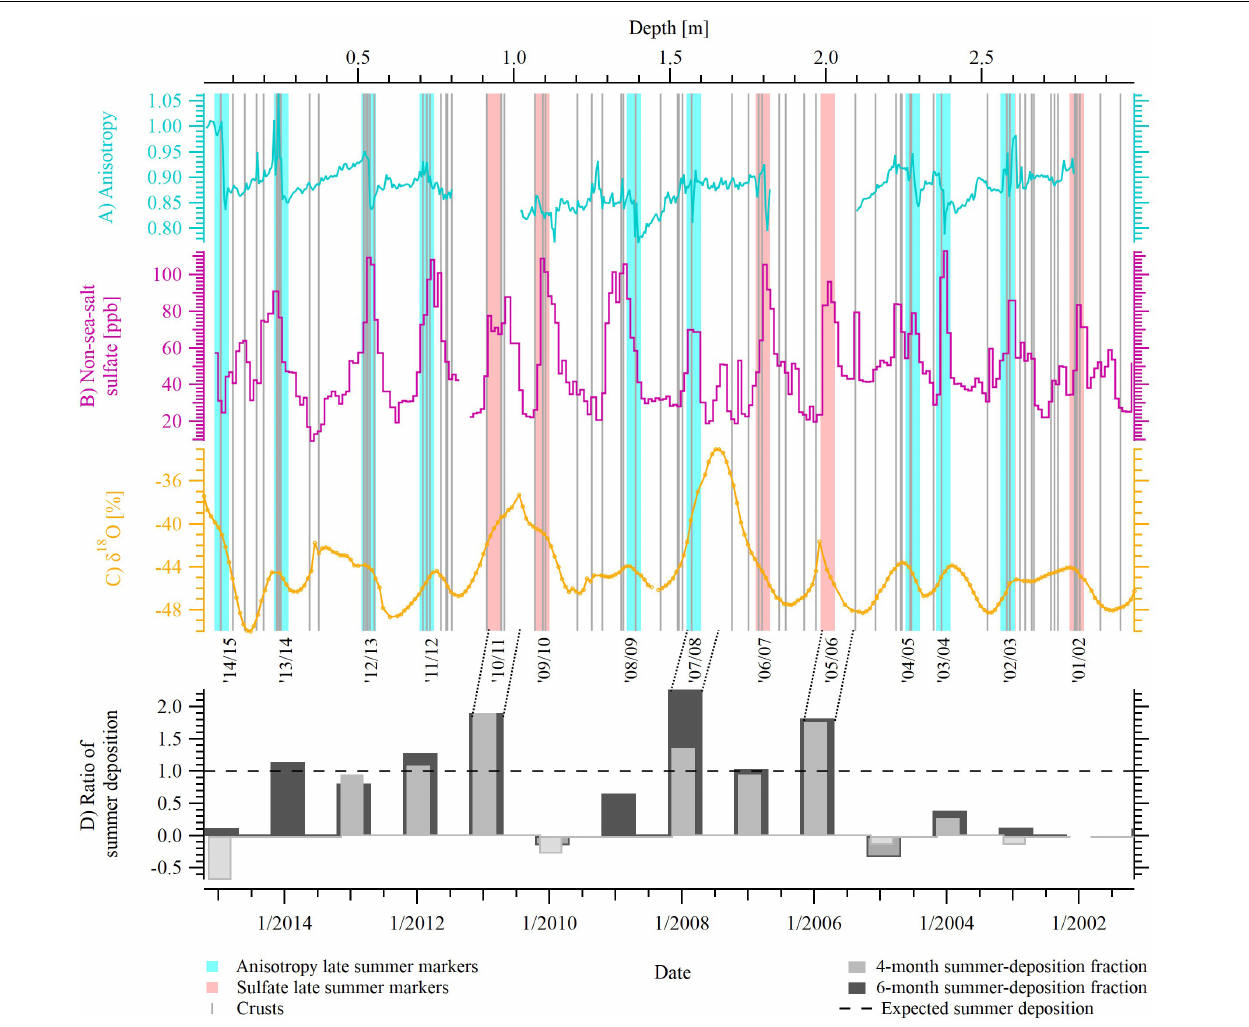
FIGURE 7 | Comparison of (A) geometric anisotropy, (B) non-sea-salt sulfate, and (C) stable water isotoe δ 18 O; summer markers are based on seasonality in geometric anisotropy and completed using sulfate peaks; (D) ratio between expected and observed snow accumulation during the 4-month and 6-month summer period derived from AWS 9; color code according to